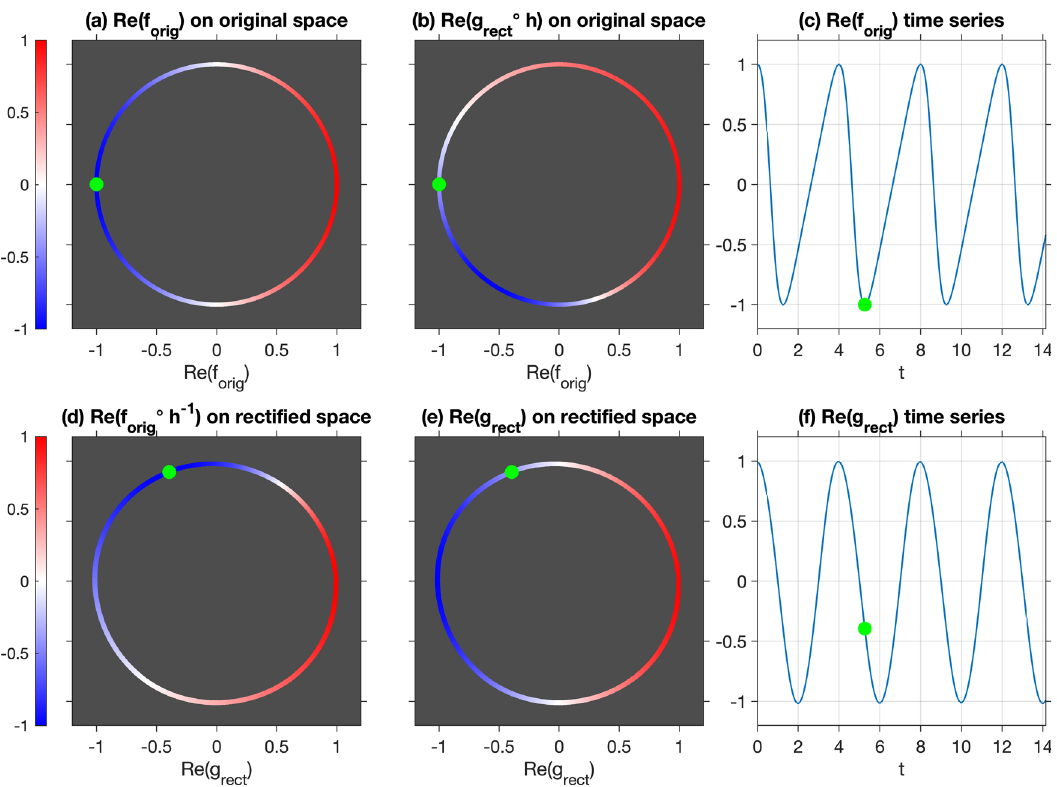
is faster when θ lies dt